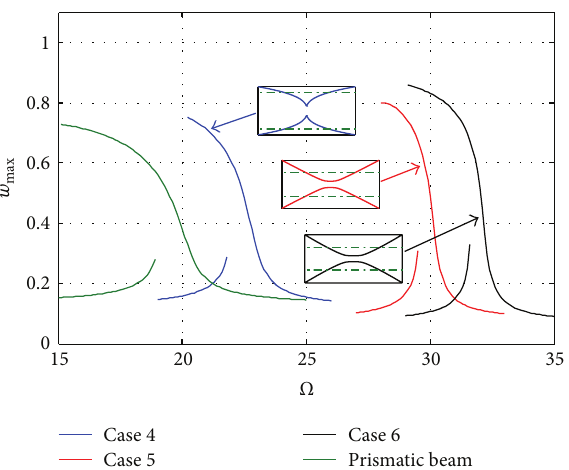
Figure 6: Frequency response curve of different optimized shape: Case 4–Case 6.